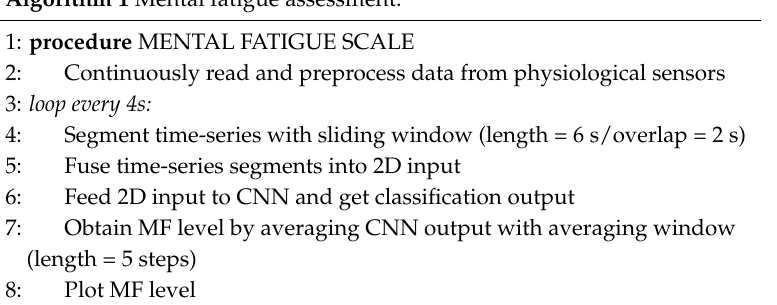
Algorithm 1 Mental fatigue assessment.